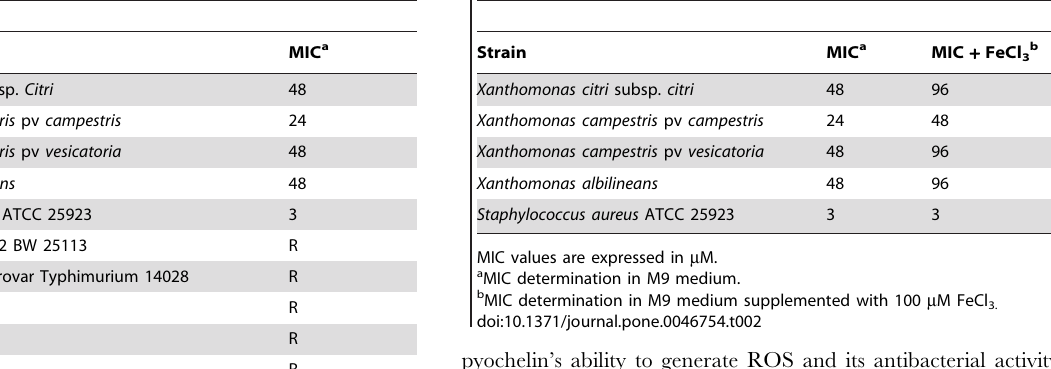
Table 1. MIC of pyochelin against selected bacterial strains. Table 2. Influence of iron on the MIC of pyochelin.